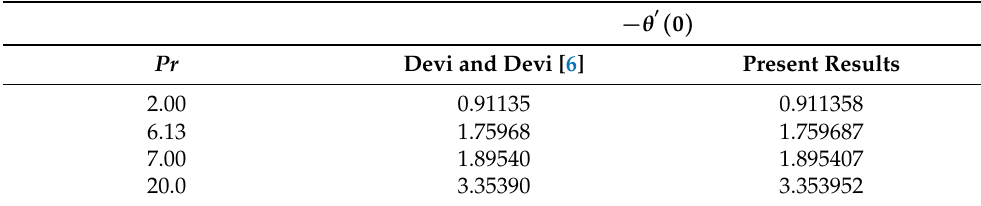
Table 5. Comparison of − θ (cid:48) ( 0 ) at different values of Pr with Rd = φ 1 = φ 2 = Hg = Γ = Fr = fw = 0, see Devi and Devi [6].